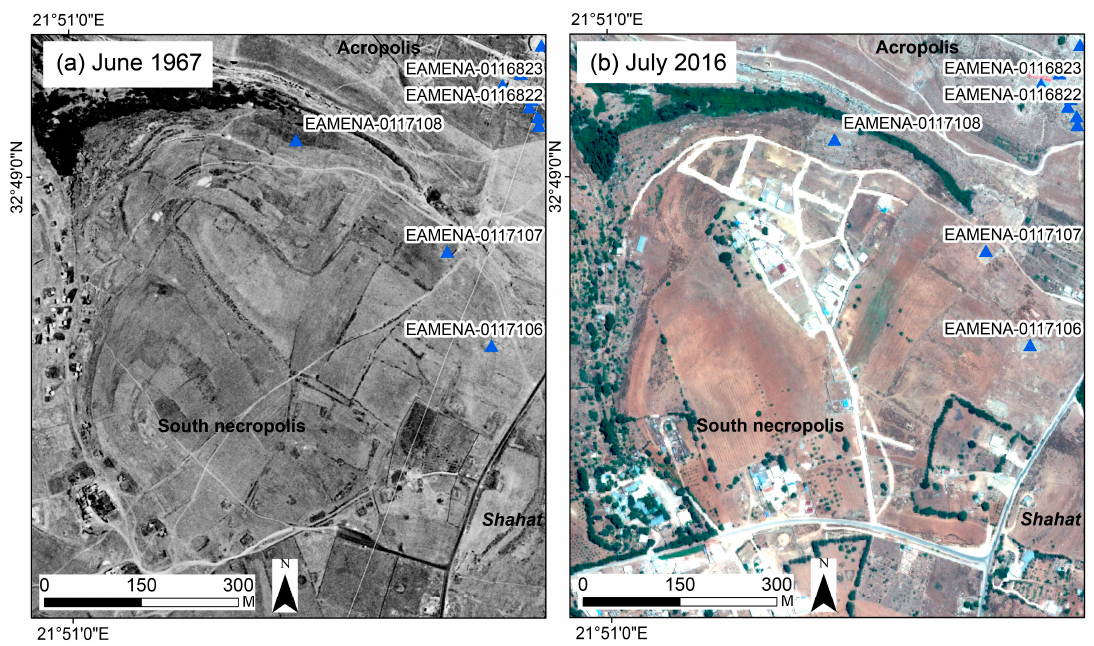
Figure 10. Comparison of ( a ) KH7 (7 June 1967) and ( b ) GeoEye-1 (5 July 2016) images showing damage to the area to the west of Shahat and immediately to the south of Cyrene. GeoEye-1 image 5 July 2016 © DigitalGlobe, Inc. All Rights